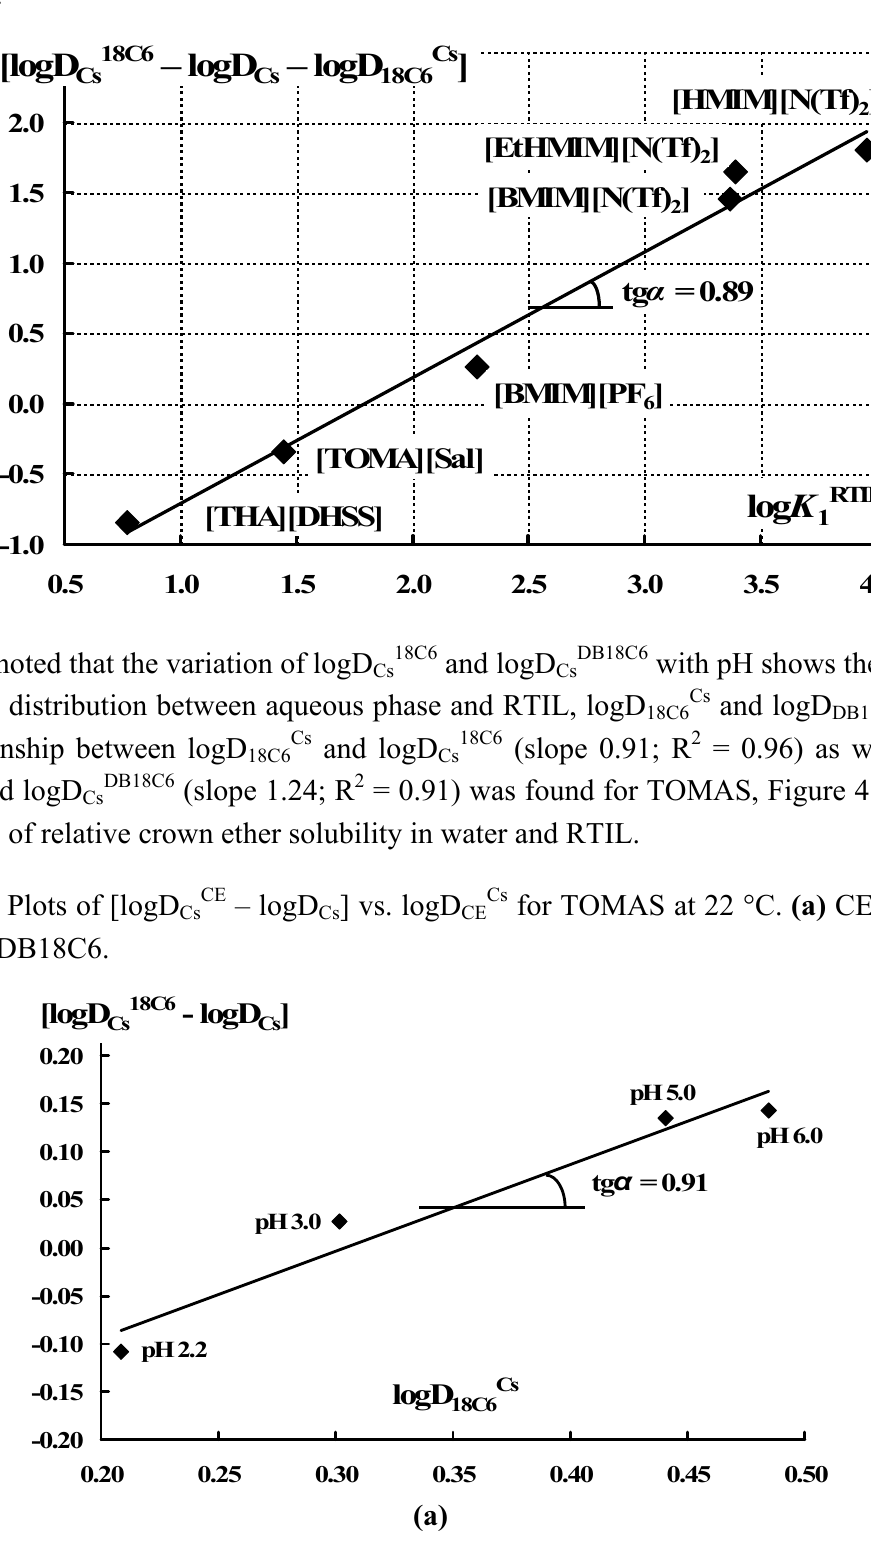
− logD 18C6Cs ] vs. log K 1RTIL for [TOMA][Sal], Cs